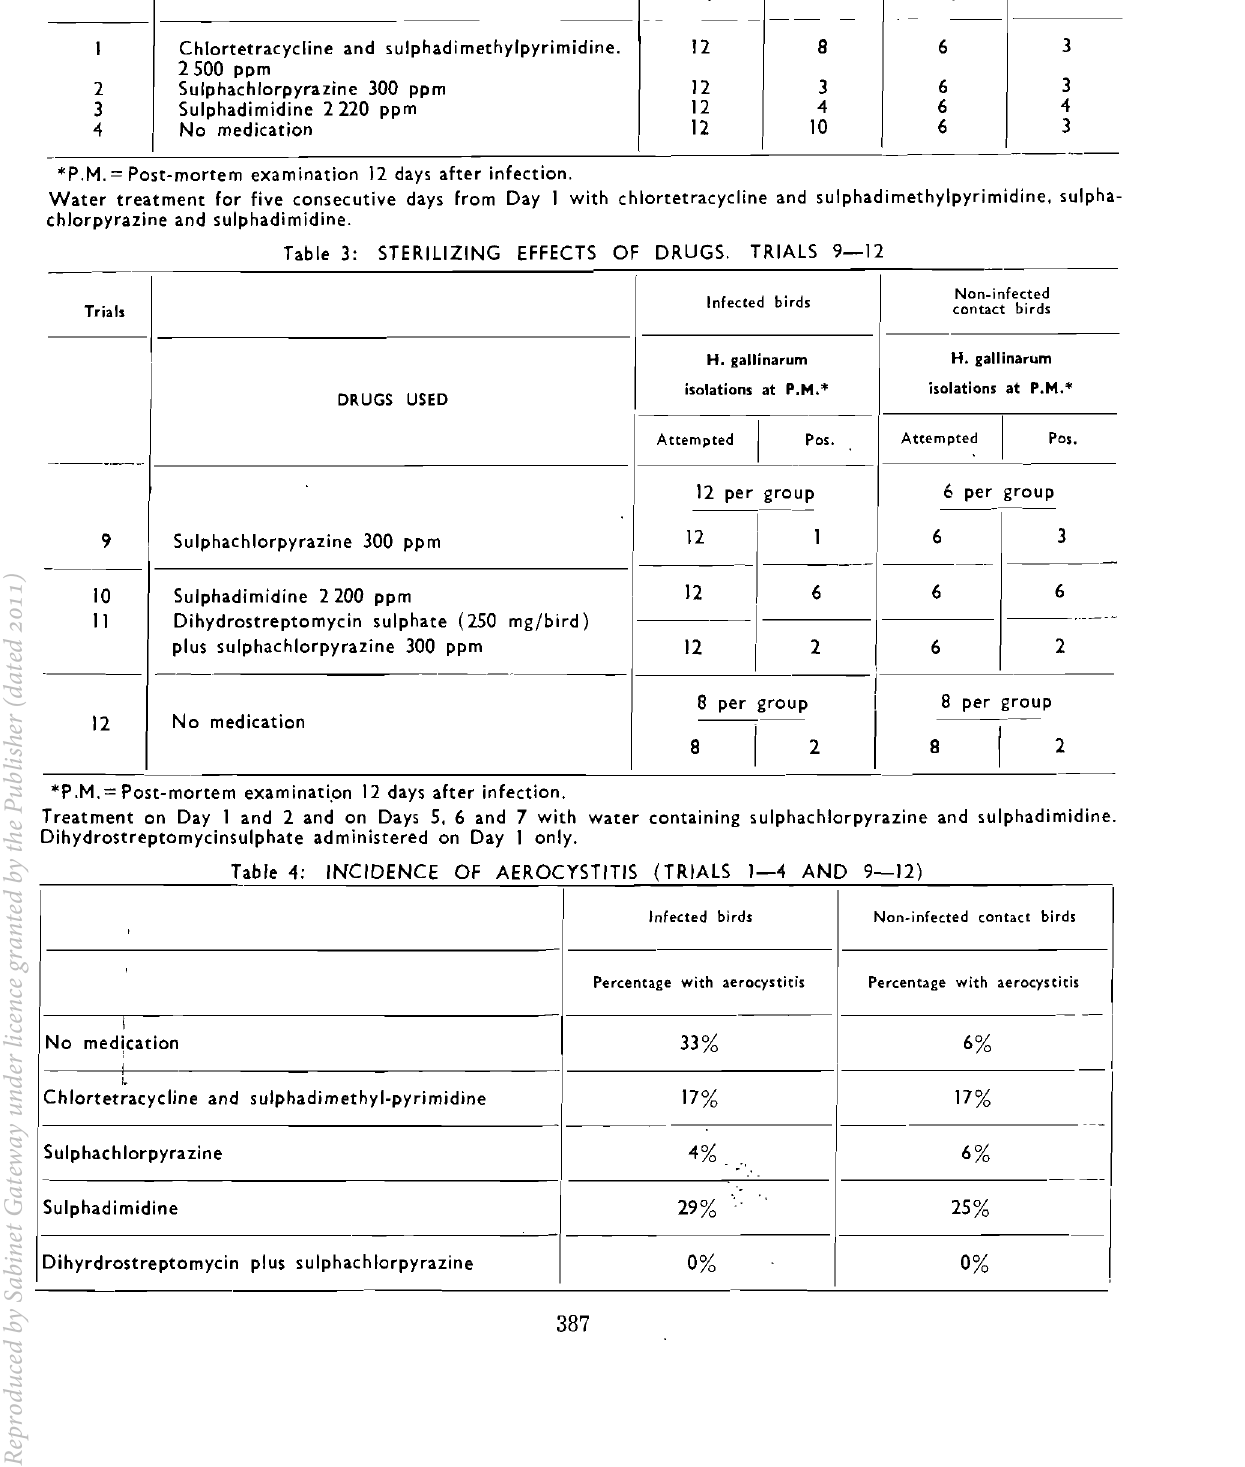
Infected birds Trials